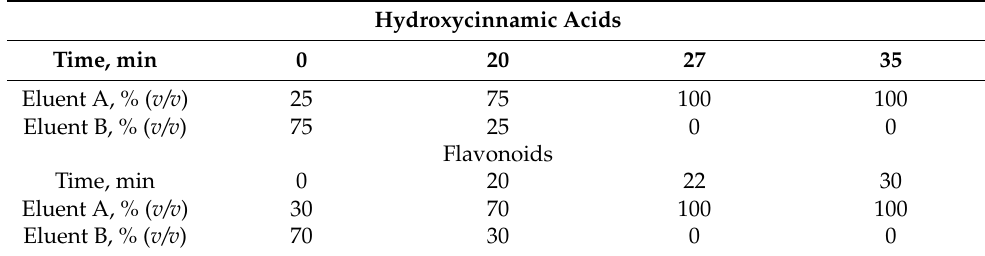
Table 7. Parameters of the gradient mode of elution of hydroxycinnamic acids and flavonoids. Hydroxycinnamic